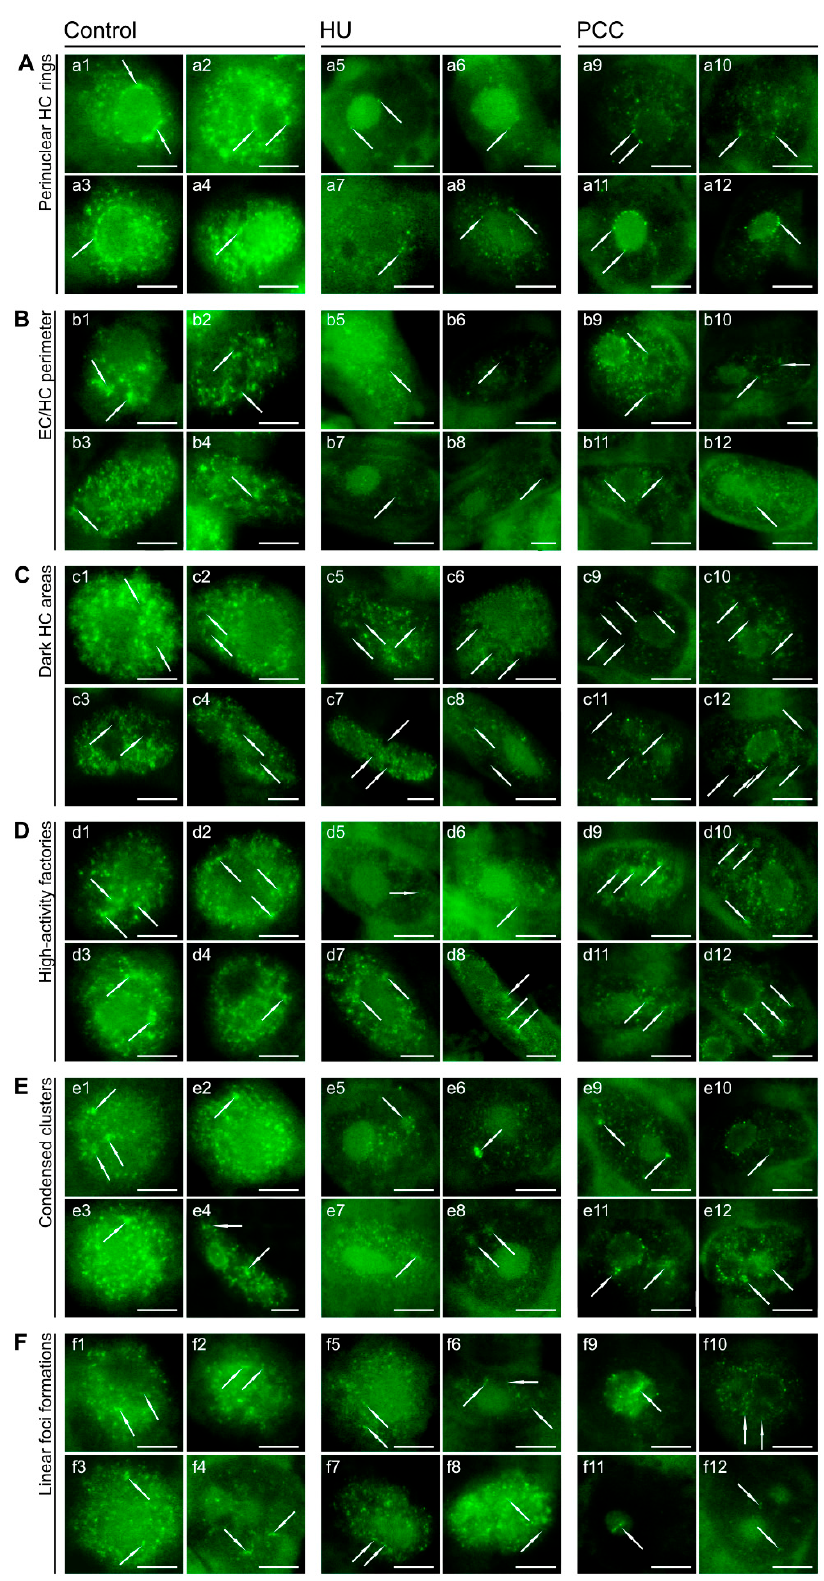
Figure 6. The differences between various characteristic pRb activity details (all marked with white arrows) under normal conditions, after induction of replication stress and PCC. ( A ) The perinucleolar rings that are very easily recognizable in control cells are usually composed of a large number of small foci that tend to form into minor clusters. Due to the lowered number of active foci in HU